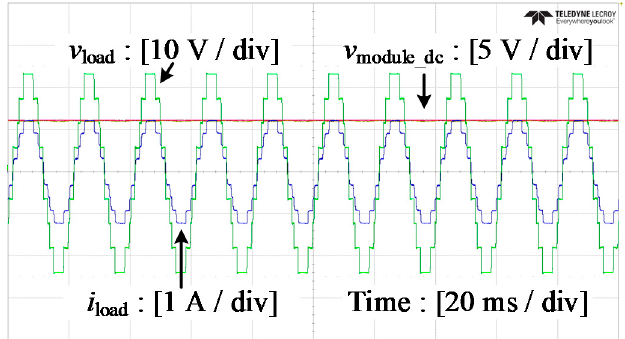
Figure 17. Experimental results of the lattice converter with harmonic elimination modulation.